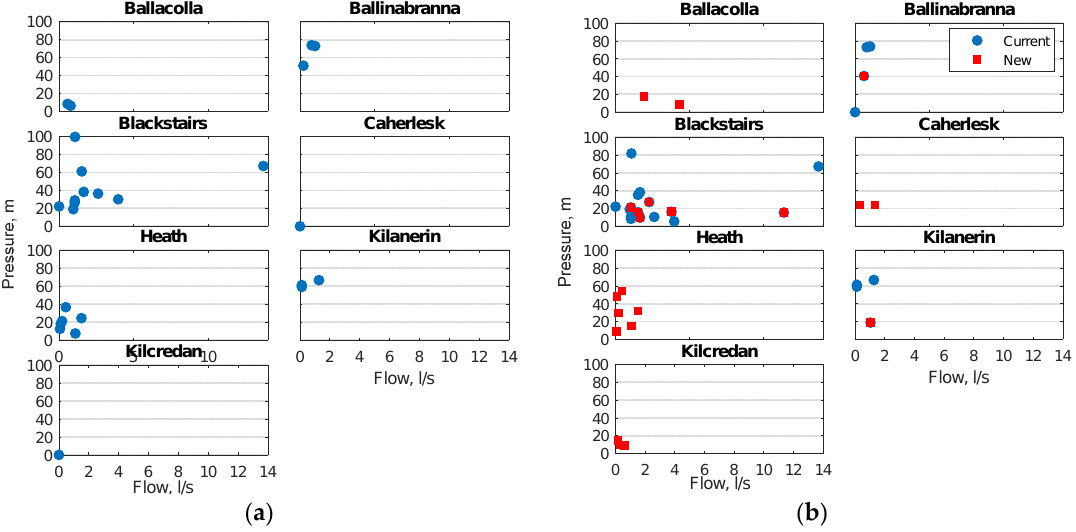
Figure 3. Flow and pressure at each PAT replacing the existing PRVs/BPTs in the network, Scenario 1 ( a ) or at the new proposed sites, Scenario 2 ( b